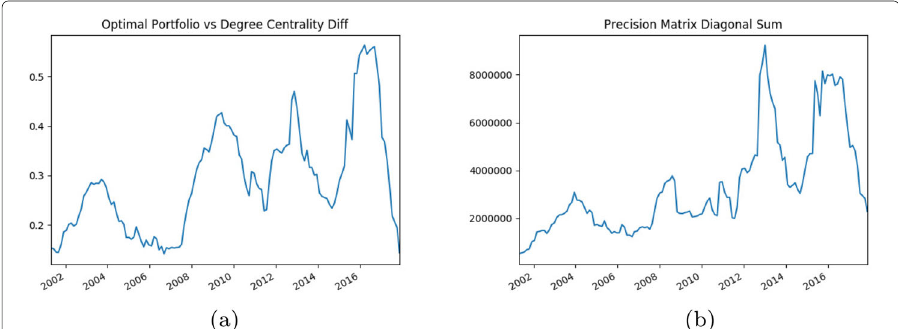
Fig. 10 L 2 difference between the weight placed on each node in the optimal portfolio vs degree centrality of each node (left) and the sum of the precision matrix diagonal (right). The differences between the optimal